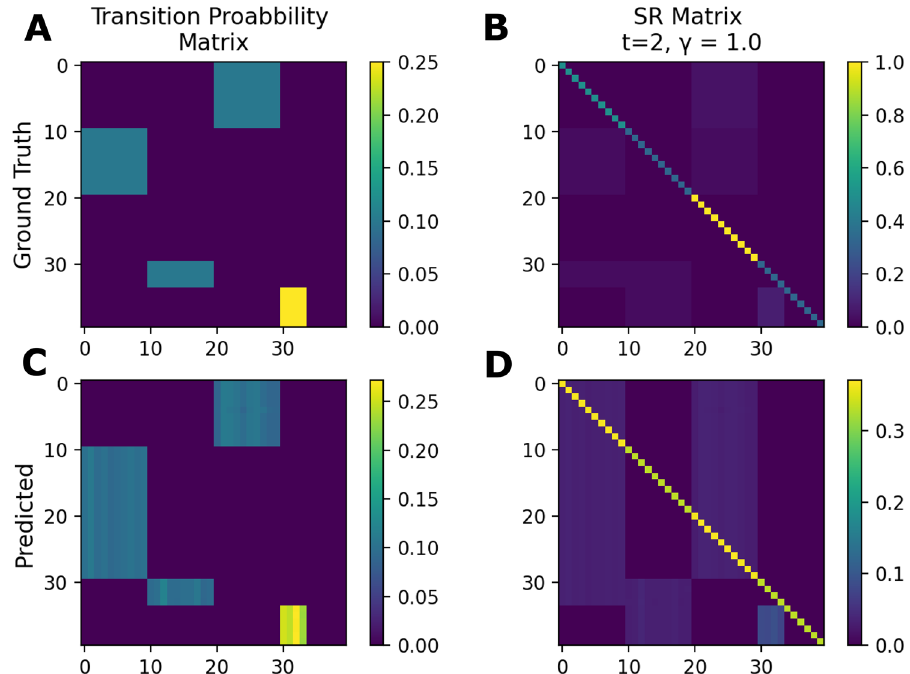
Figure 7. Word transition probability and word successor representation matrices: After training on the linguistic data, the neural network predicts the word transition probabilities (TP) and the word successor representations (SR). As ground truth, the calculated TP matrix ( A ) and the SR matrix ( B ) for t = 2 and γ = 1 are shown. The corresponding predictions learned by the network are very similar to the ground truth in both cases ( C , D ). States (0–39) correspond to words. 0–9: adjectives, 10–19: verbs, 20–29: nouns, 30–34: pronouns, 35–40: question words.